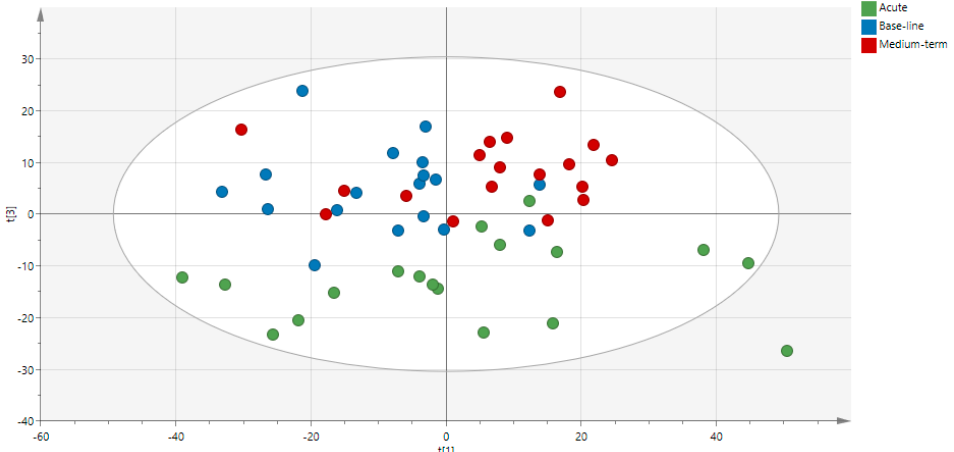
Figure 1. Non-supervised PCA of the plasmatic metabolome at baseline (before consumption of Physalis peruviana L. ) and after acute consumption and medium-term consumption.